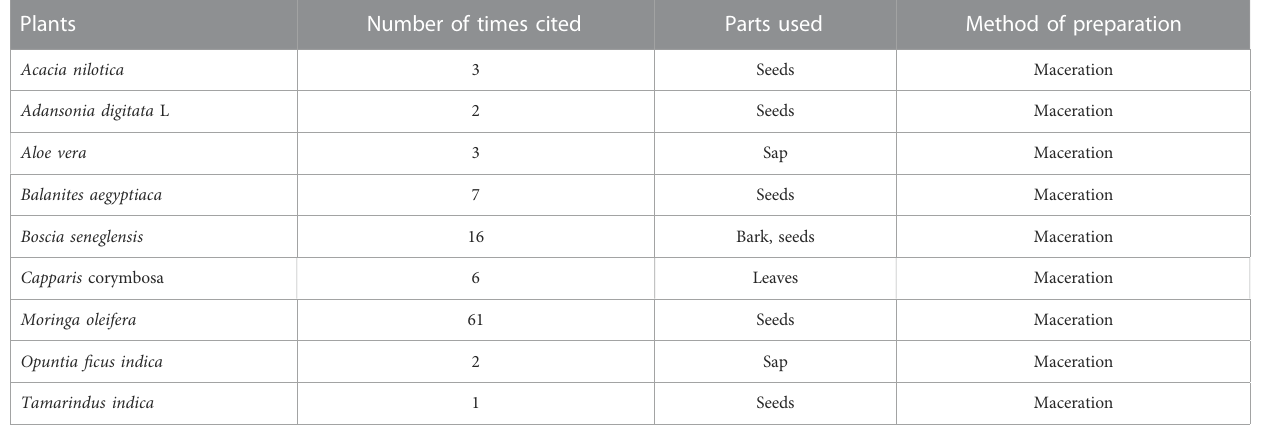
TABLE 1 Plants with a potential potabilization power on raw water identi fi ed during the survey.